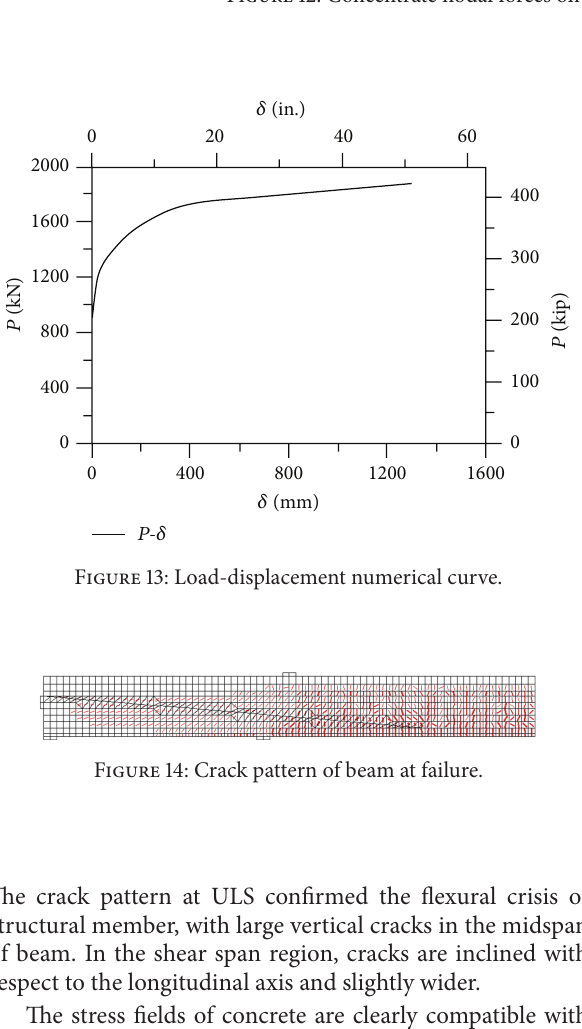
Figure 12: Concentrate nodal forces on steel plates due to external prestressing cables.